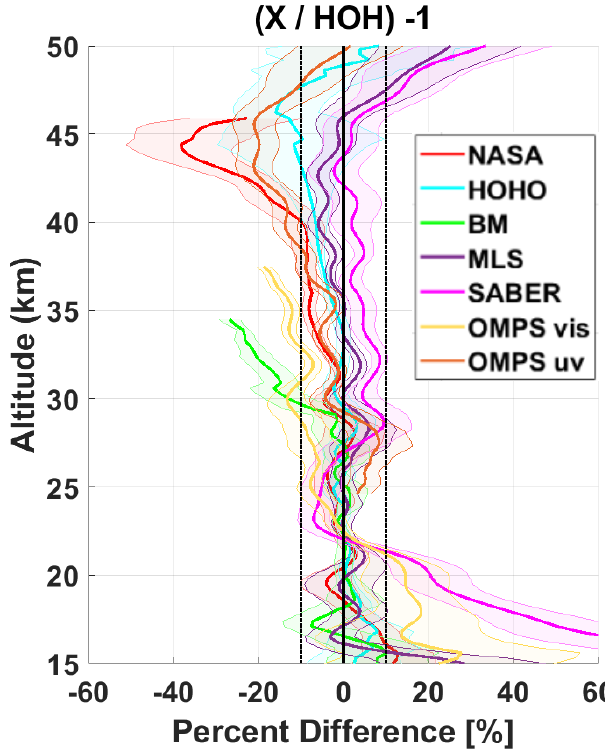
Figure 6. The average relative difference profile between the ozone profiles measured by the various HOPS instruments compared to the ozone profile measured by the HOH lidar. The shaded range gives the ± 2 standard deviations of the mean and indicates the statistical confidence interval at the 95% uncertainty